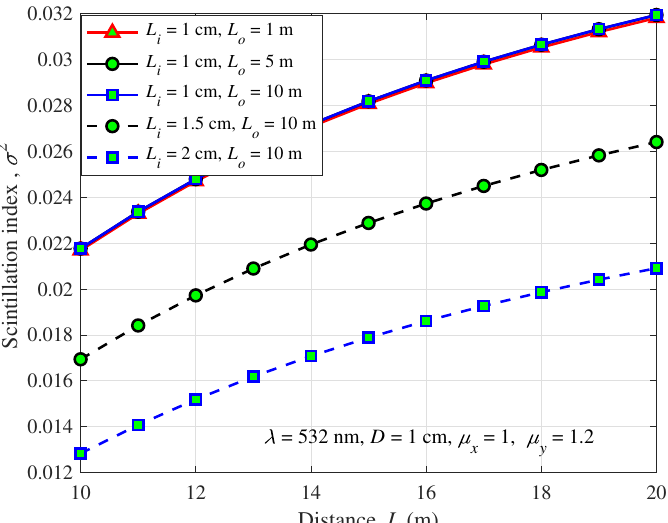
Figure 10. Scintillation index of a spherical wave versus the propagation distance for different inner and outer scales.